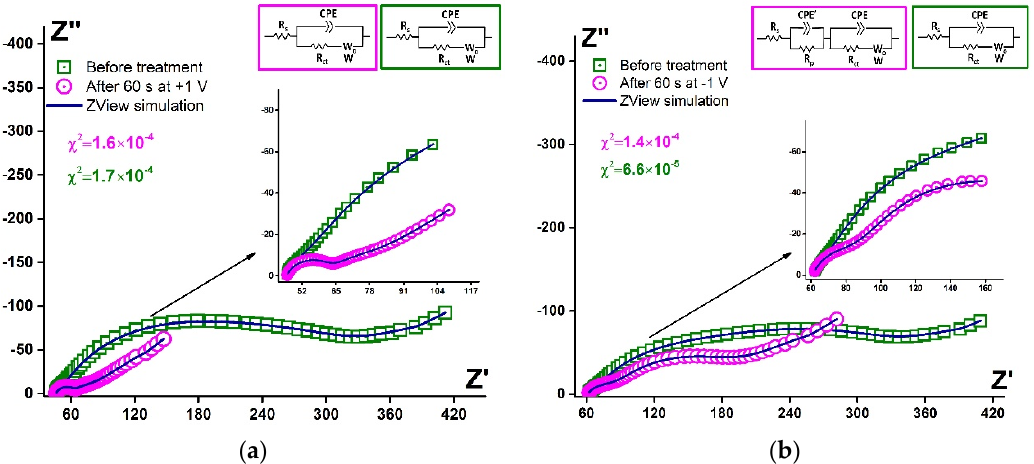
Figure 6. Simulated Nyquist plots (blue curves) and experimental data for Au disc/LC-18 before (green squares) and after (pink circles) potentiostatic treatment at ( a ) +1 V; ( b ) –1 V. Solution: 0.025 M K 3/4 [Fe(CN) 6 ] in PBS (7.4). Insets: equivalent circuits.